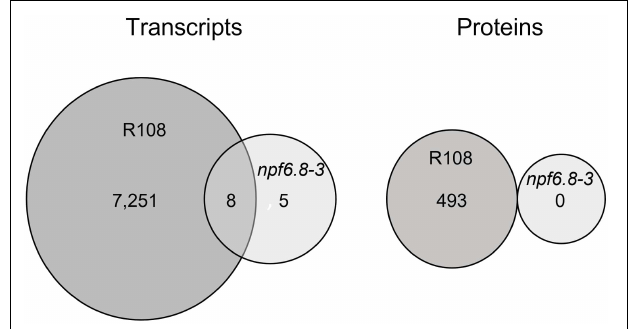
FIGURE 3 | Transcriptomic and proteomic response to nitrate of the primary root tip of R108 and npf6.8-3 . Venn diagrams show the sets of transcripts and proteins that are differentially accumulated in R108 or npf6.8-3 in response to 5 mM nitrate and their overlapping. Transcripts and proteins were considered as differentially accumulated if the adjusted p-value is under 0.05 based on the false discovery rate procedure of Benjamini and Hochberg (1995).